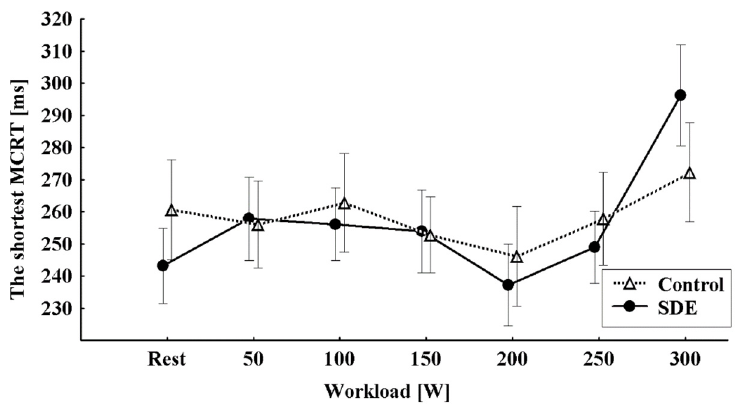
Figure 3. The shortest multiple-choice reaction times (MCRT) during the graded exercise test to exhaustion in Control and after 30 h of sleep deprivation and exercise (SDE).